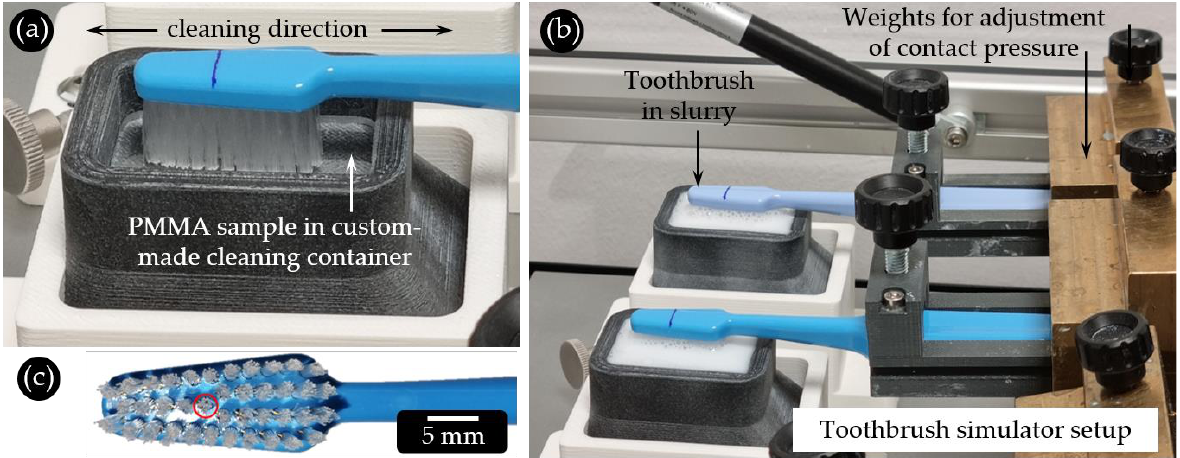
Figure 1. ( a ) Abrasion test setup. The bristles of the mounted toothbrush are parallel to the sample substrate in a custom-made container . ( b ) Overview of the brushing simulator during testing. ( c ) substrate in a custom-made container. ( b ) Overview of the brushing simulator during